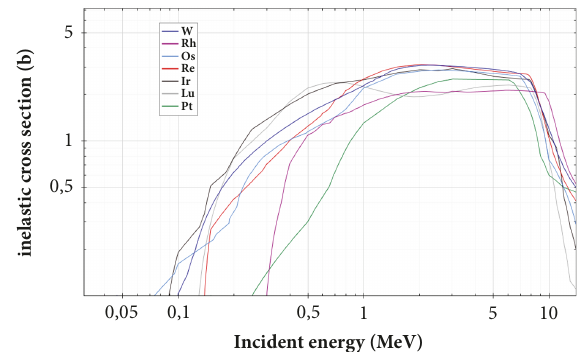
Figure 10: Inelastic microscopic cross sections of W, Rh, Os, Re, Ir, Lu, and